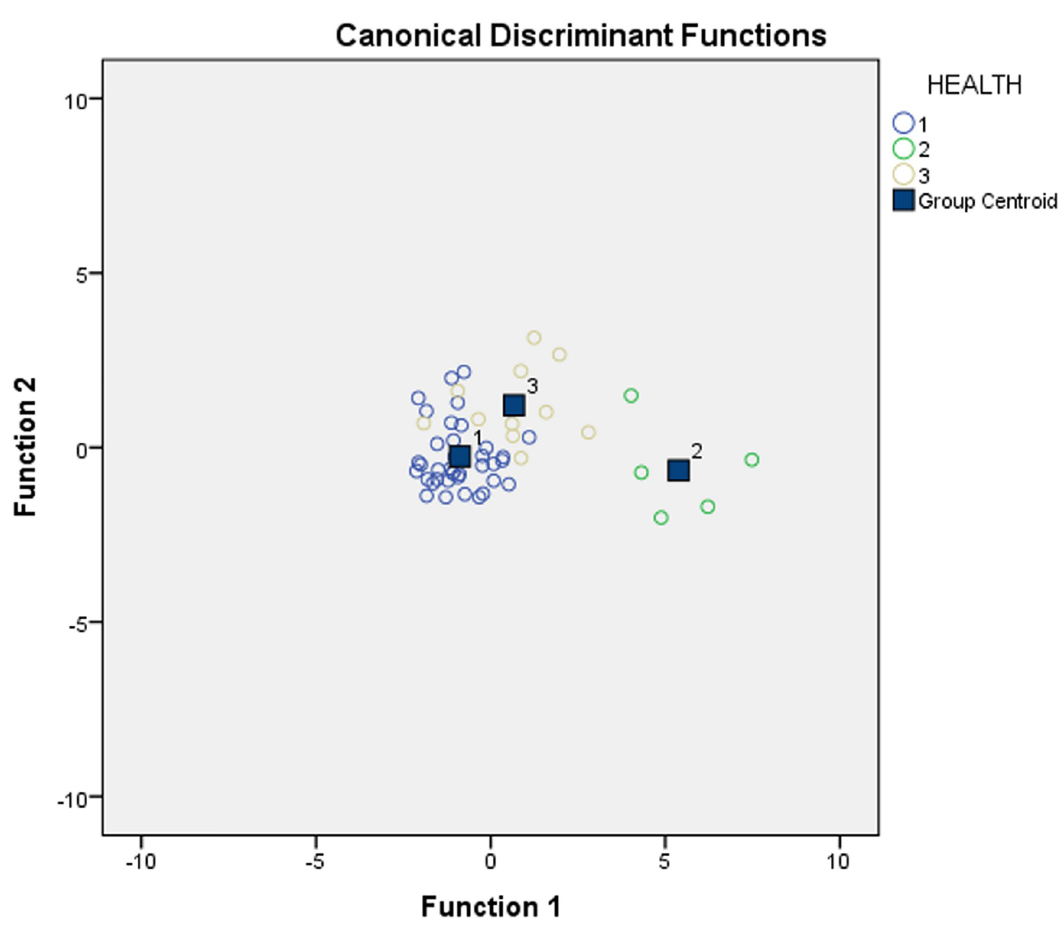
Fig 1. Canonical discriminant functions describing the cluster patterns of brain natriuretic peptide results for Group 1 (healthy), Group 2 (clinically ill), and Group 3 (newly diagnosed) zoo-housed gorillas. The three groups are significantly different as demonstrated by cluster